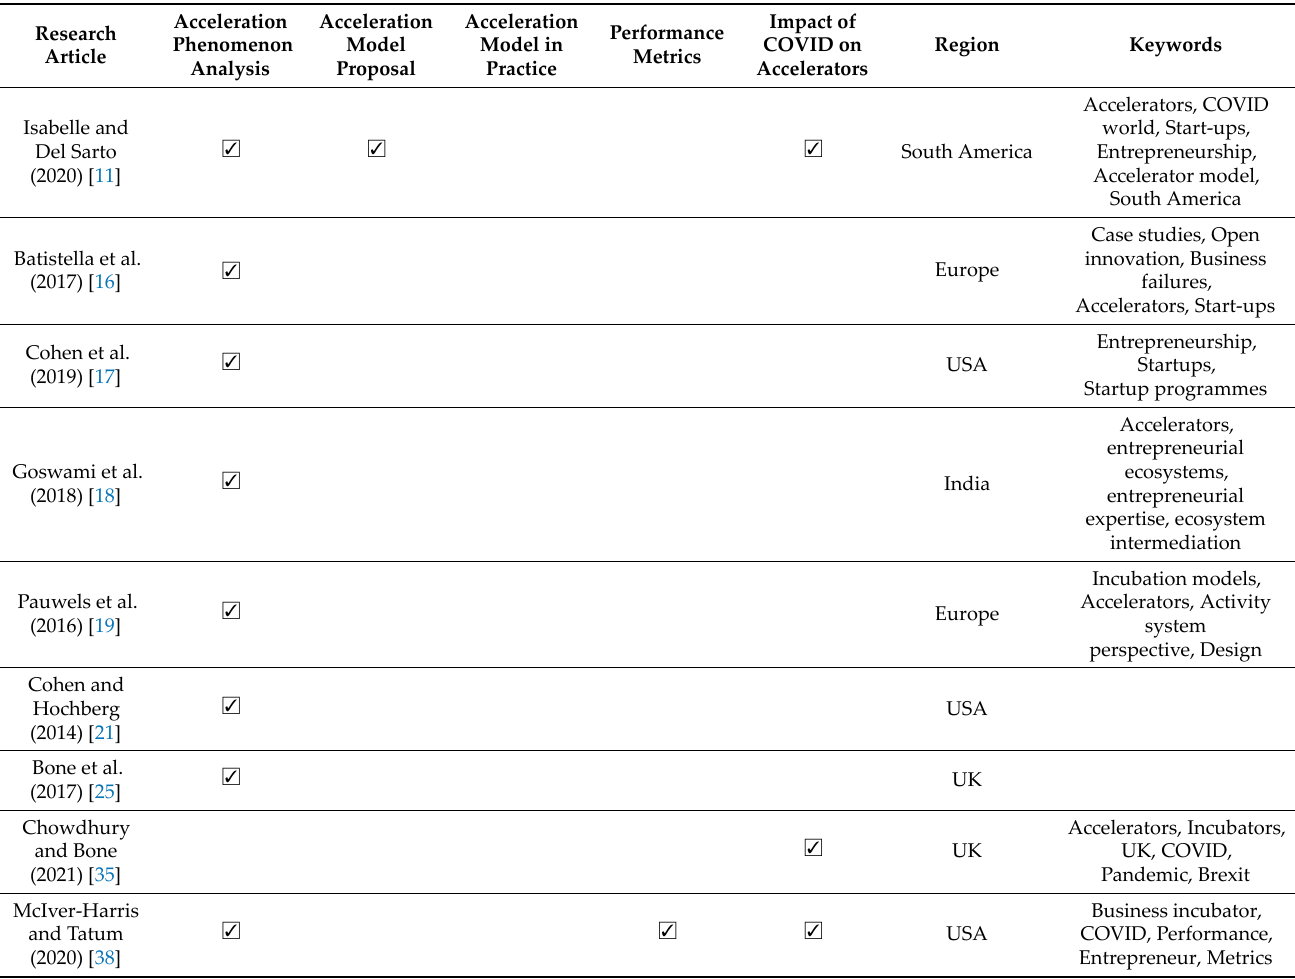
Table 3. Literature review on start‑ups